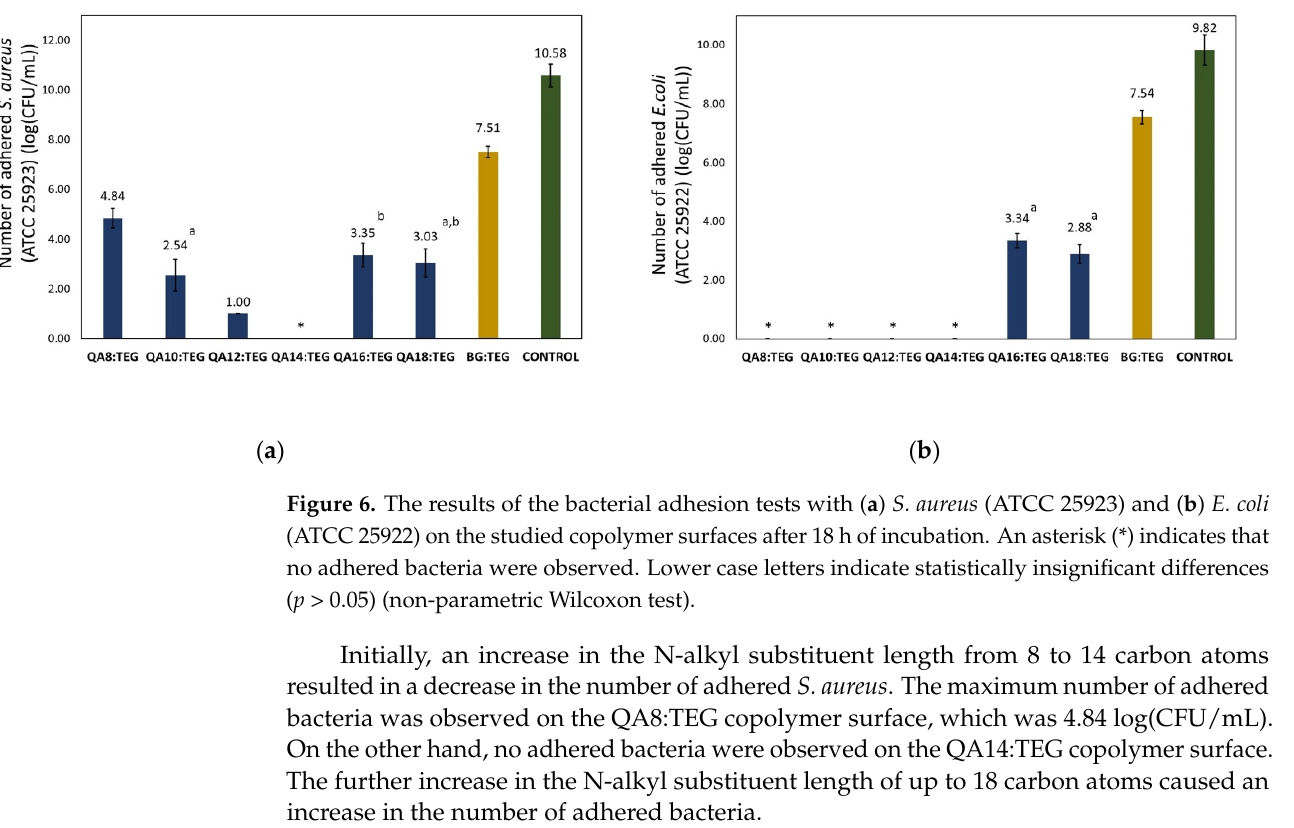
Figure 5. The images of deionized water droplets on the studied copolymer surfaces obtained from the goniometry camera. Lower case letters indicate statistically insignificant differences ( p > 0.05) (non-parametric Wilcoxon test).